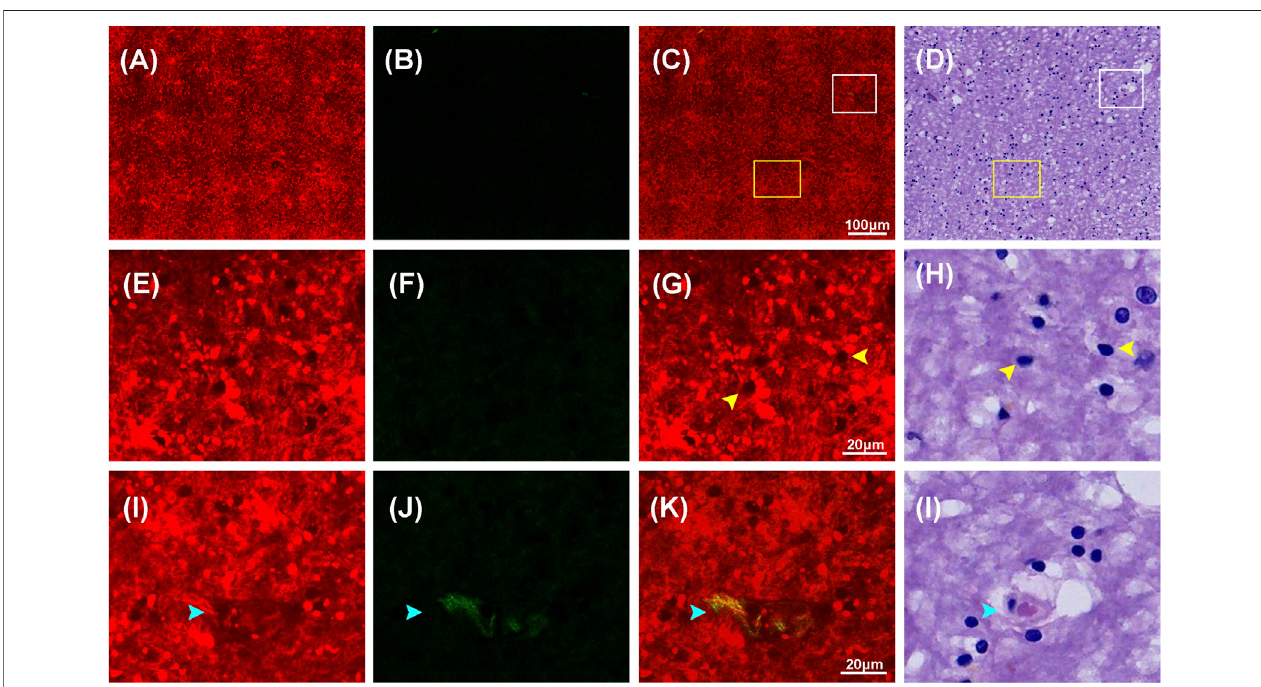
FIGURE3 | Representative MPM images and the corresponding images ofH&E stained normal brain(white matter) tissue. (A – D) TPEF, SHG, TPEF/SHG overlaid images, and corresponding image of H&E stained normal brain tissue. (E – H) The magni fi ed TPEF, SHG, TPEF/SHG overlaid images, and corresponding H&E image of the selected area (yellow square box) in Figure 3C . (I – L) The magni fi ed TPEF, SHG, TPEF/SHG overlaid, and corresponding H&E image of the selected area (white square box) in Figure 3C . Yellow arrowheads: cells in normal brain tissue; cyan arrowhead: blood vessel in normal brain